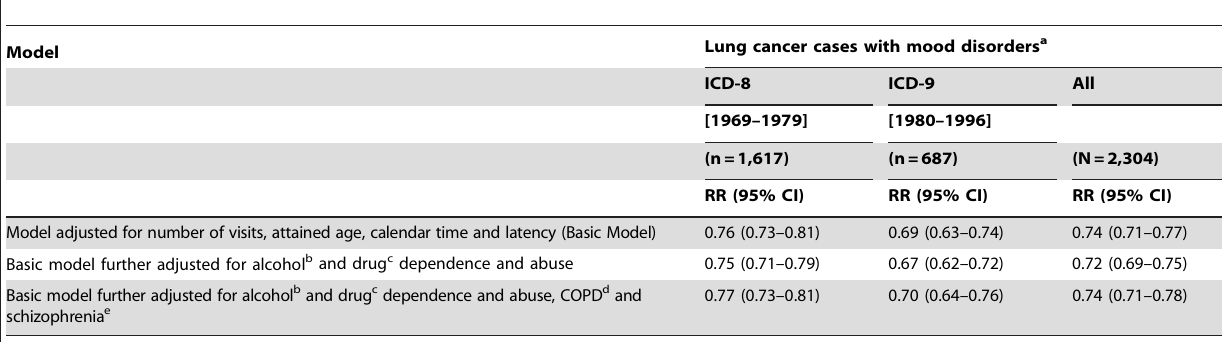
Table 6. Relative risks and 95% confidence intervals for lung cancer overall and by period of discharge from the United States Veterans Affairs Inpatient Cohort: White males with at least one hospital admission between July 1, 1969, and September 30,